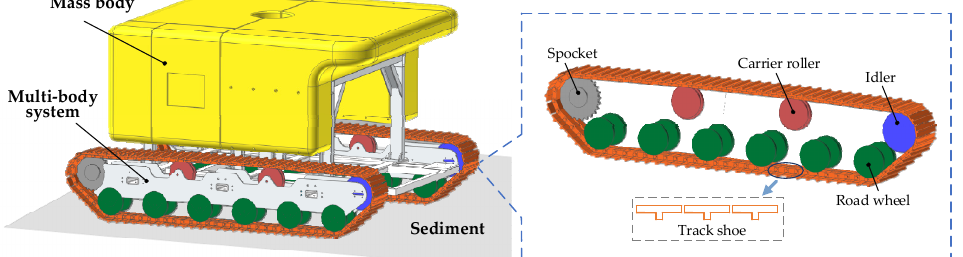
Figure 9. Structural model and crawler system of the DSLV virtual prototype.